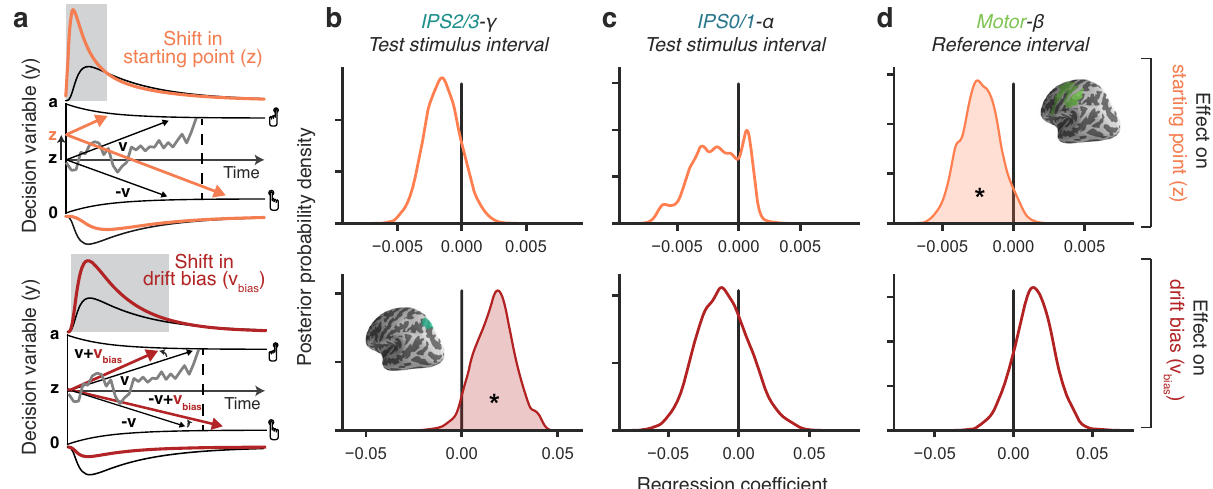
Fig. 7 | Cortical signals predicting starting point and bias of evidence accu- mulation.a SchematicofbiasingmechanismswithinDDMwithcollapsingbounds. Grayline,examplesingle-trialtrajectoryofdecisionvariable.Blacklines,meandrift and RT distributions for unbiased decisions. Gray-shaded area: part of RT dis- tributions for which biased parameter translates into overt choice bias. Orange lines: mean drift and RT distributions for a bias in starting point. Red lines: mean